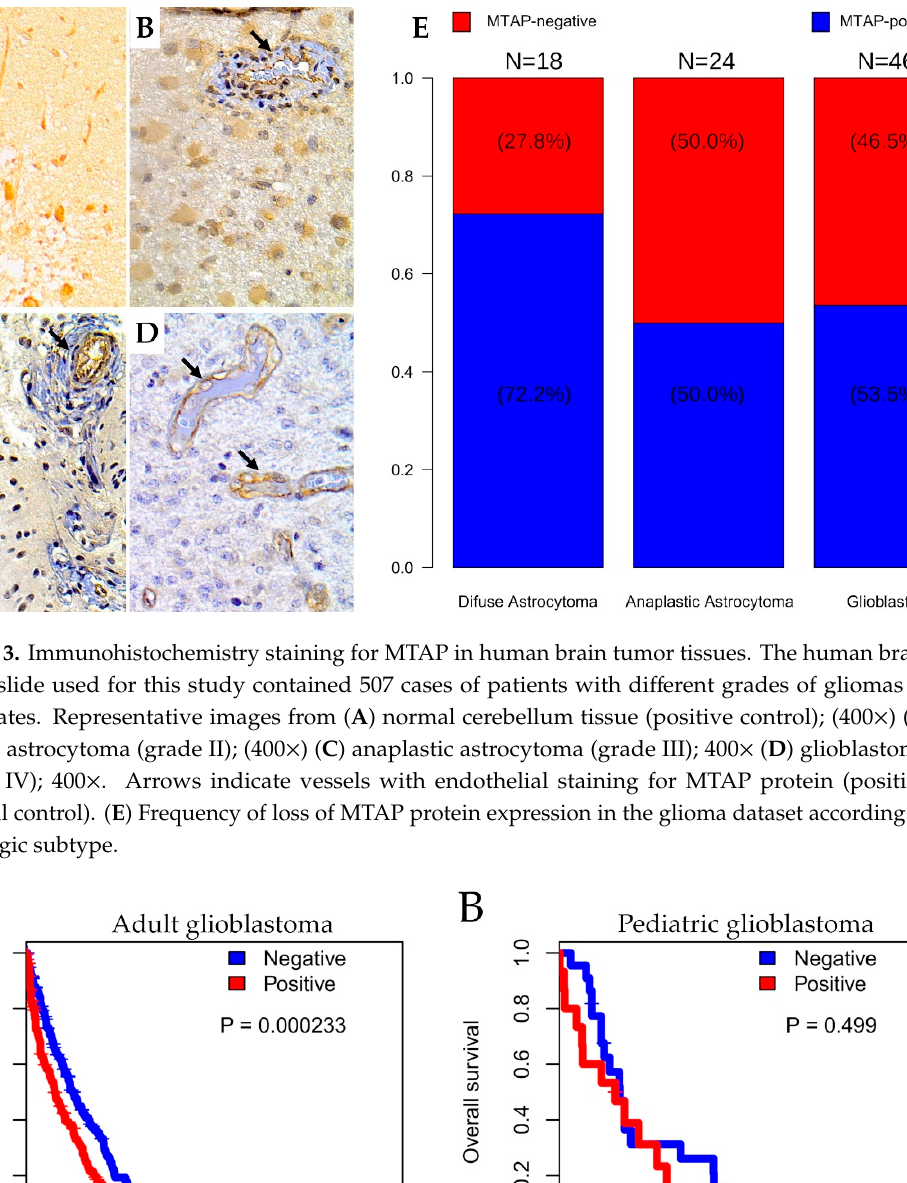
Figure 4. Kaplan–Meier analysis for MTAP expression associated with patient survival. Overall survival for a series of patients with glioma diagnosis according to histopathological grade. Shown for ( A ) adult glioblastoma, ( B ) pediatric glioblastoma, and ( C ) TCGA-GBM dataset status and ( D ) five-year disease-free survival (DFS) for TCGA-GBM dataset. 3.3. MTAP Cell Line Editing and Differential Gene Expression To further underpin the MTAP biological role in gliomas, the U251 cell line, which expressed MTAP , was transfected with MTAP CRISPR/Cas9 KO to create the stable knockout clones (U251MTAP − / − ). On the other hand, SW1088 cells that normally do not express MTAP were transduced by the MTAP human lentivirus to establish MTAP expression clones (SW1088MTAP+/+). Stable cell lines were confirmed by Western blotting post puromycin selection (Supplementary Figure 1). After MTAP gene editing, the transcriptomic profiles of U251MTAP − / − and SW1088MTAP+/+ cells as well as control cells (U251EV and SW1088LB) and parental cells (U251WT and SW1088WT) were evaluated for the expression of specific genes using the NanoString PanCancer Pathways Panel, which assessed thirteen canonical pathways (Notch, Wnt, Hedgehog, chromatin modification, transcriptional regulation, DNA damage control, transforming growth factor-beta (TGF-beta), mitogen-activated protein kinase (MAPK), The Janus kinase/signal transducers and activators of transcription (JAK/STAT), Phosphoinositide 3-kinase (PI3K), RAS, cell cycle, and apoptosis). In the U251 cells, we found that the U251MTAP − / − clone showed 17 differentially expressed genes in comparison with controls, with seven ( ANGPT1, NGFR, FN1, COL11A1, SPP1, RASGRF1, and MAPK10 ) being associated with the PI3K/RAS/MAPK pathways, three ( TGFBR2, THBS1, and BMP5 ) with the TGF- β pathway, two ( IDH2 and ERBB2 ) belonging to the Driver pathway, and five genes